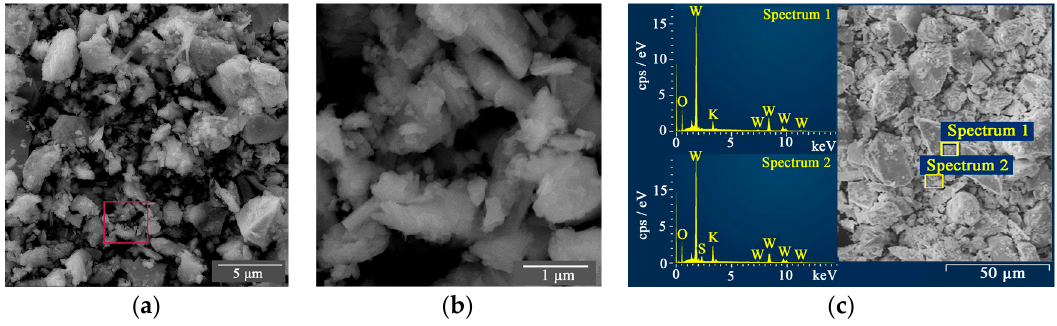
Figure 14. ( a , b ) SEM images and ( c ) EDX spectrum for WS 2 synthesized using commercial WO 3 as precursor.